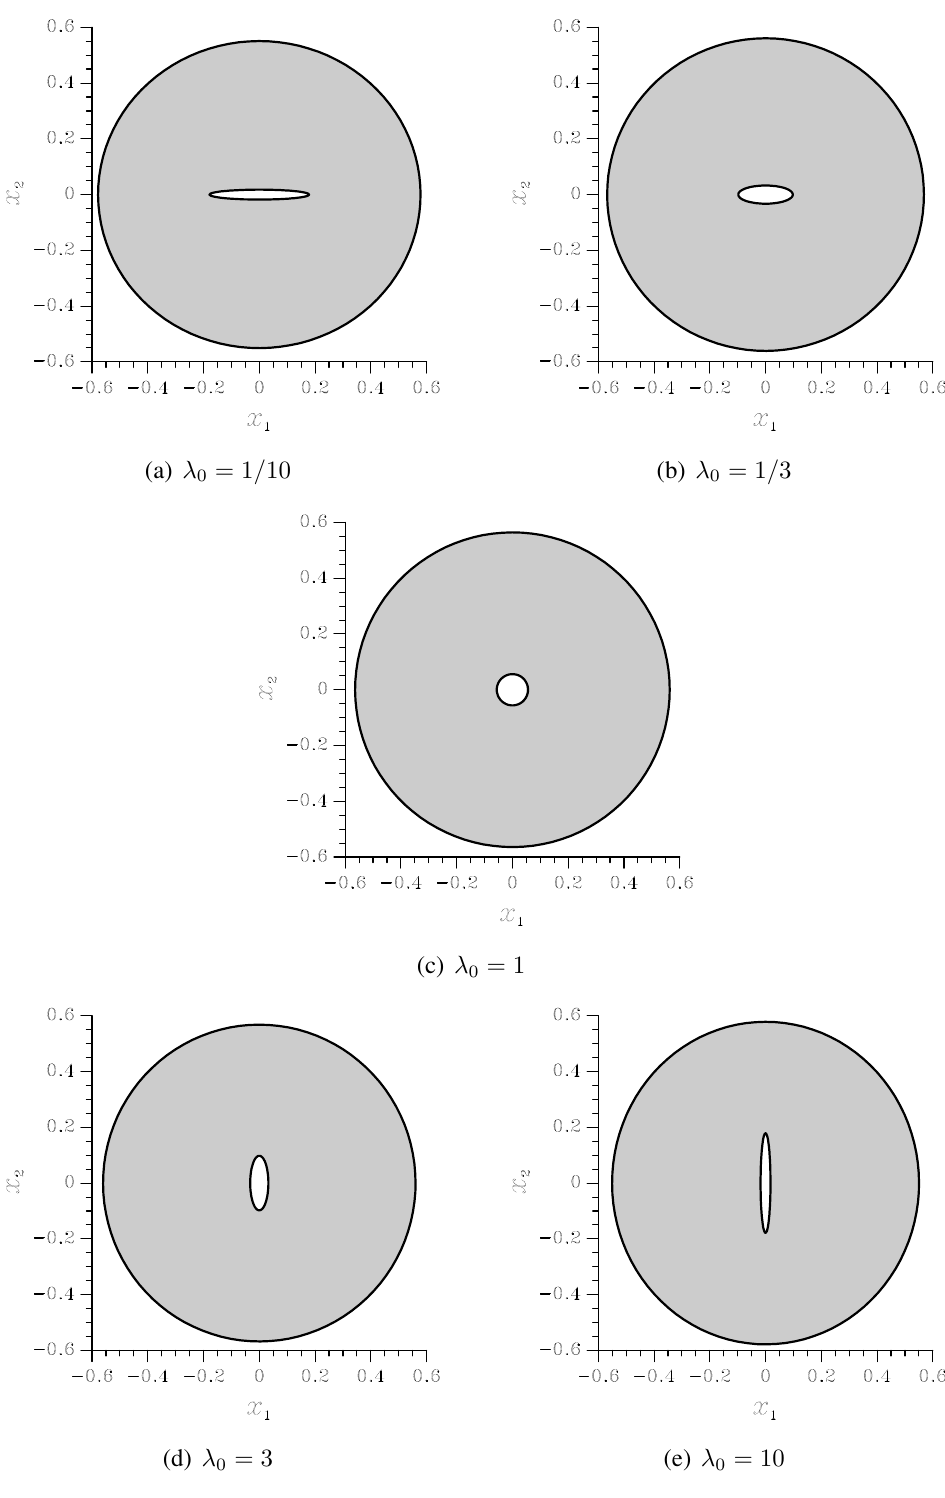
= 0 . 01 and varying void aspect ratio 0